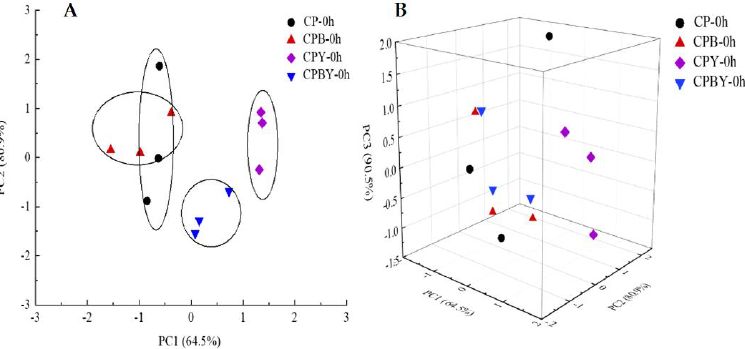
Figure 3. PCA scatter plots (2D and 3D) of four groups of unfermented specimens. ( A ): two-dimension; ( B ): three-dimens ion. CP-0 h, unfermented chickpea milk; CPB-0 h, unfermented chickpea milk with papain treatment; CPY-0 h, unfermented chickpea milk with yam addition; CPBY-0 h, unfermented chickpea milk with papain treatment plus yam addition.